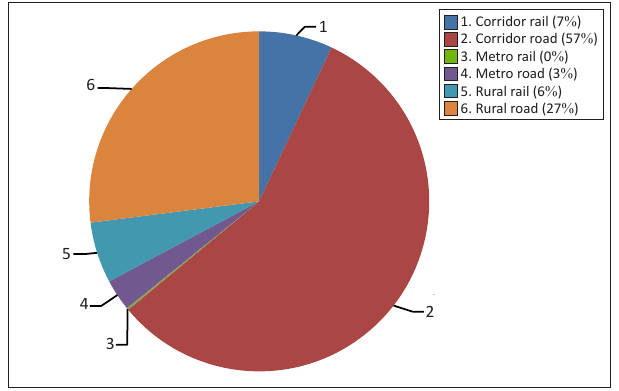
FIGURE 3: Road and rail ton-kilometre contribution to competitive typologies